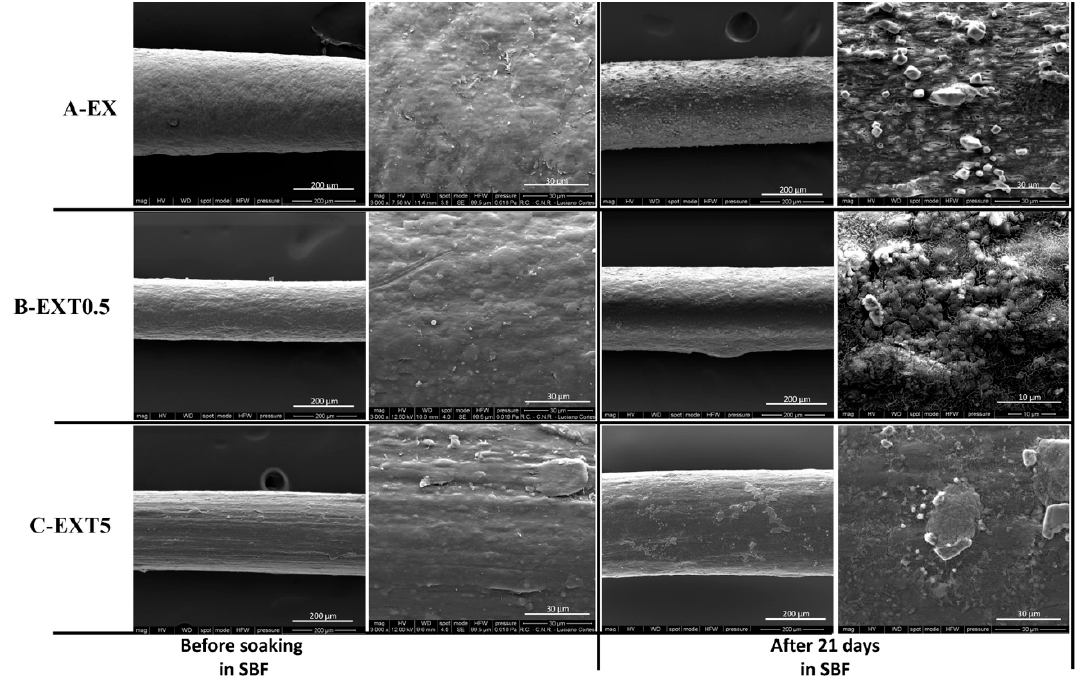
Figure 6. The bioactivity tests of EX ( A ), EXT0.5 ( B ), and EXT5 ( C ) threads.